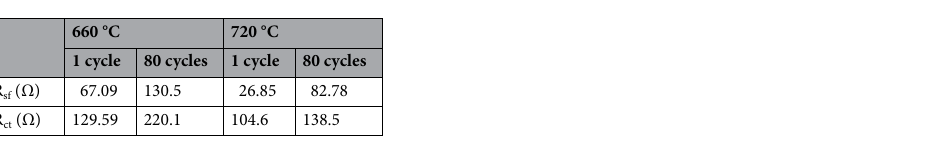
Table 2. R sf and R ct values of NCA sintered at 660 °C and 720 °C.